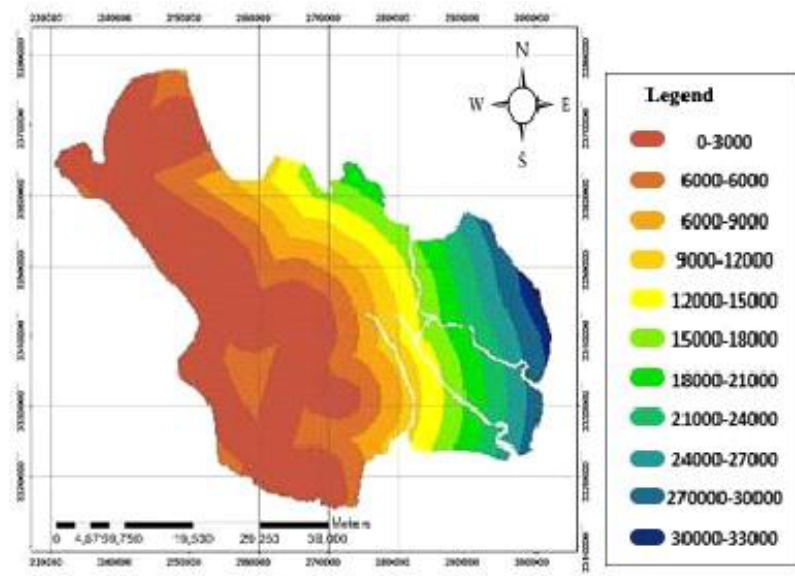
Fig. 7: Distance from transportation lines